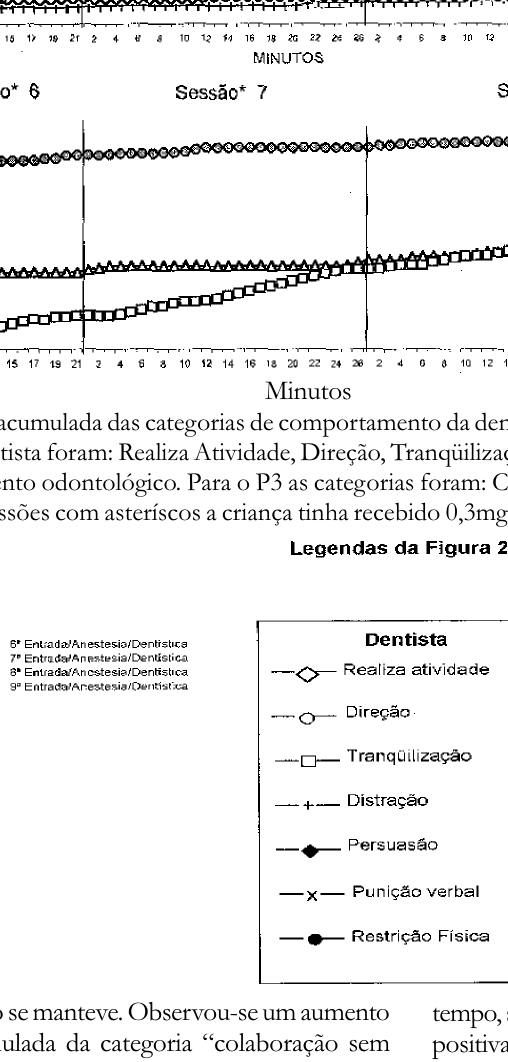
Psicologia: Reflexªo e Cr(cid:237)tica, 2004, 17(1),